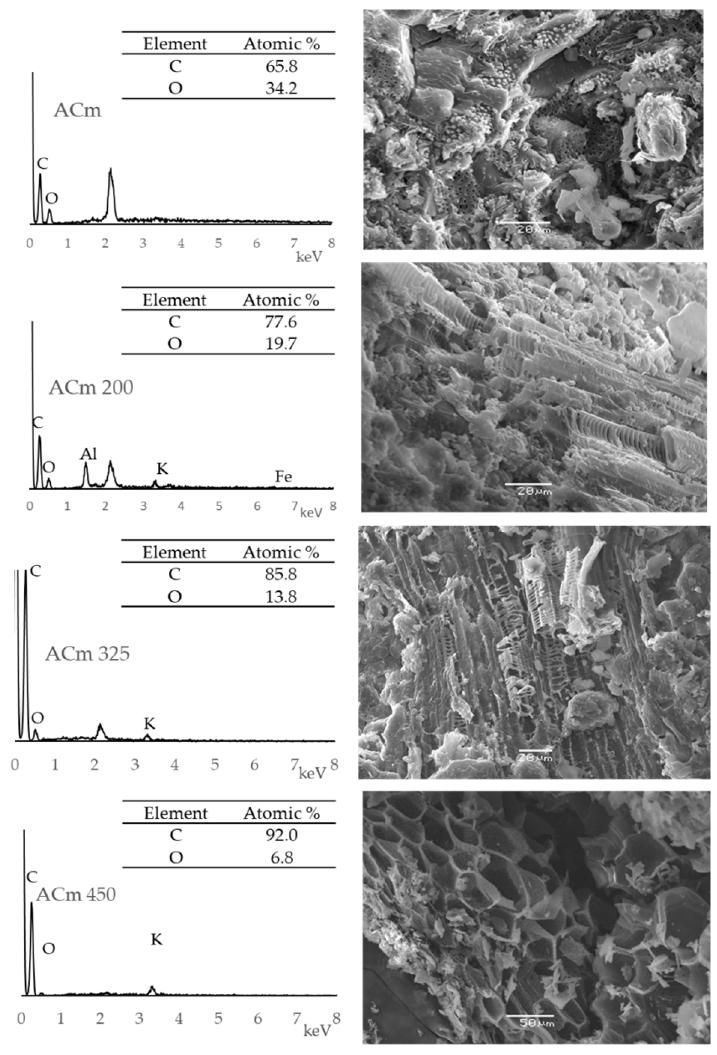
Figure 5. SEM images and their EDS of A. aculeate in medium size (4 mm) in its natural form and the three pyrolysis temperatures.